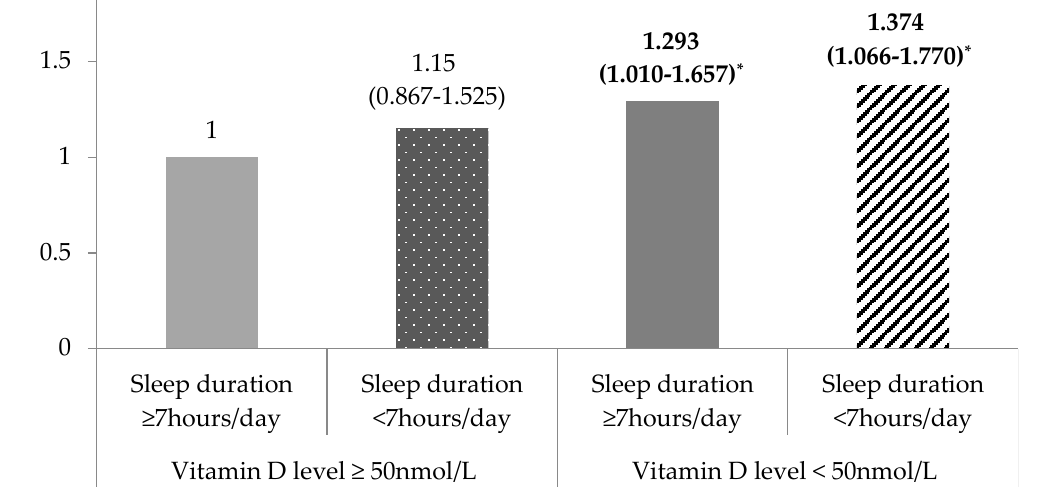
Figure 1. Adjusted odds ratio for obesity according to the 25-hydroxyvitamin D concentration and sleep duration. The odds ratios (95% confidence intervals) were calculated in reference to a serum vitamin D concentration ≥50 nmol/L and sleep duration ≥7 h using multivariate logistic regression after adjusting for age, gender, education level, monthly household income, marital status, subjective stress level, smoking status, drinking status, and physical activity (* p < 0.0001).